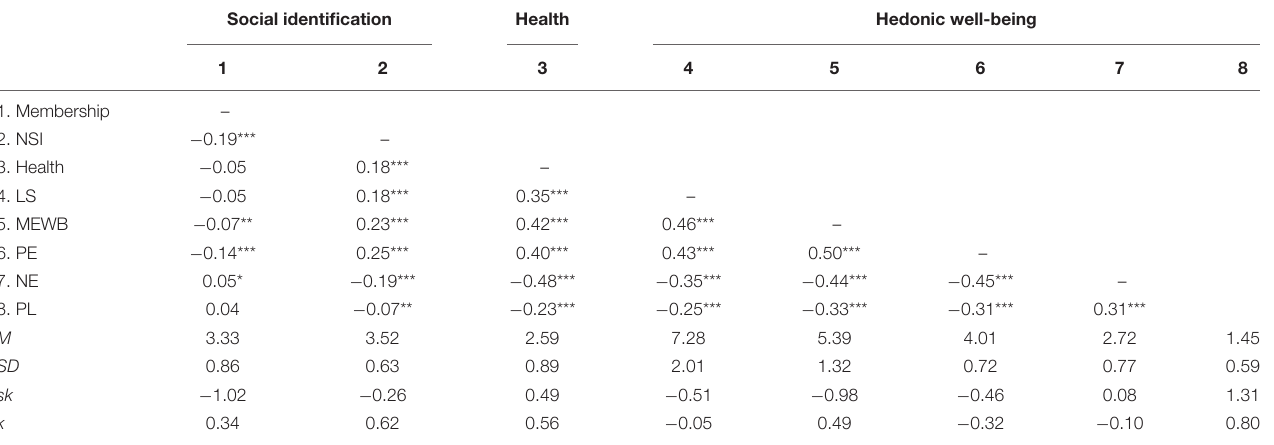
TABLE 1 | Pearson’s correlation between social identification, health, and hedonic well-being. Social identification Health Hedonic